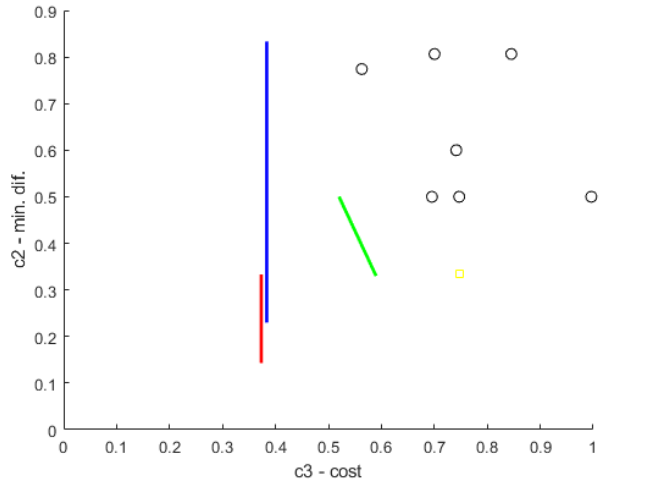
Figure 12. Comparison of population size.